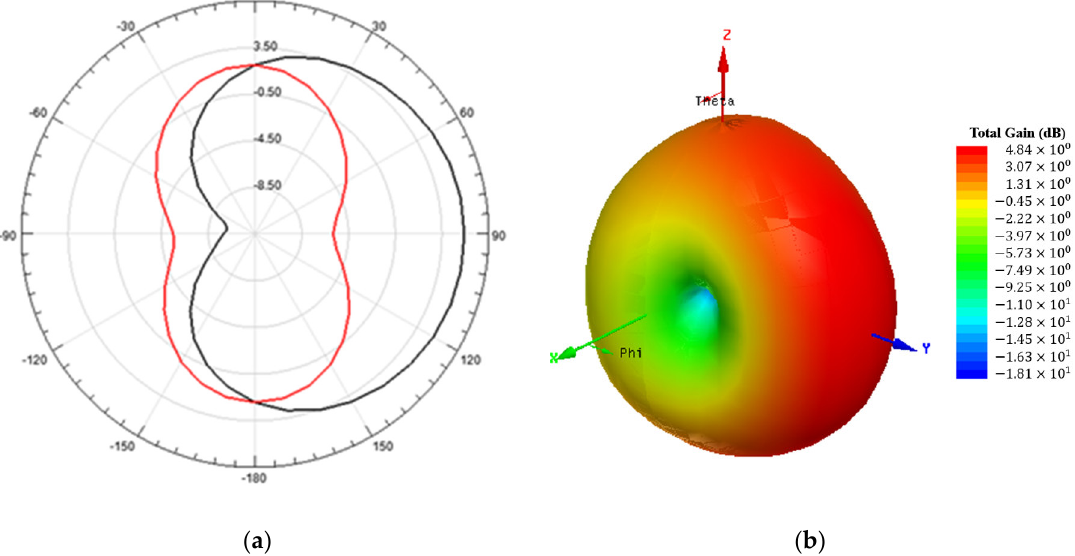
Figure 5. Simulated radiation pattern of the proposed antenna sensor at 2.25 GHz. ( a ) 2-D radiation pattern at φ = 0 ◦ (x-z plane), in red color, and φ = 90 ◦ (y-z plane), in black color. ( b ) 3-D radiation pattern, with gain total (dB) results.